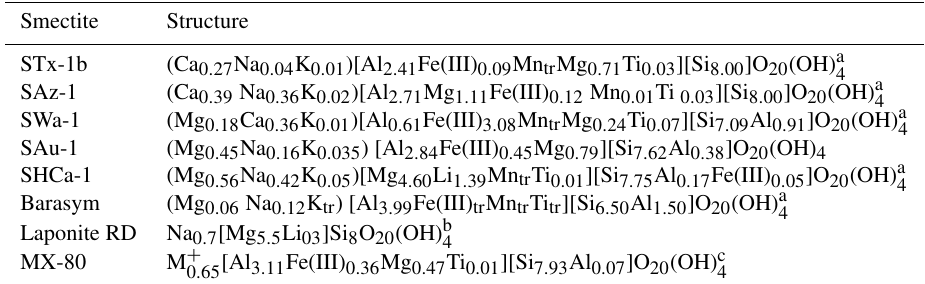
Table 1. Mineralogical composition of the investigated smectites in weight% ± 3 standard deviations (SD). Minerals STx-1b SAz-1 SWa-1 SAu-1 Smectite Calcite – – Quartz Dolomite – – – Gypsum – – Analcime Pyrite – – Opal CT K-Feldspar Sanidine – – Kaolinite – – Chlorite – Cristobalite Boehmite – – – – Sanidine Pyrite